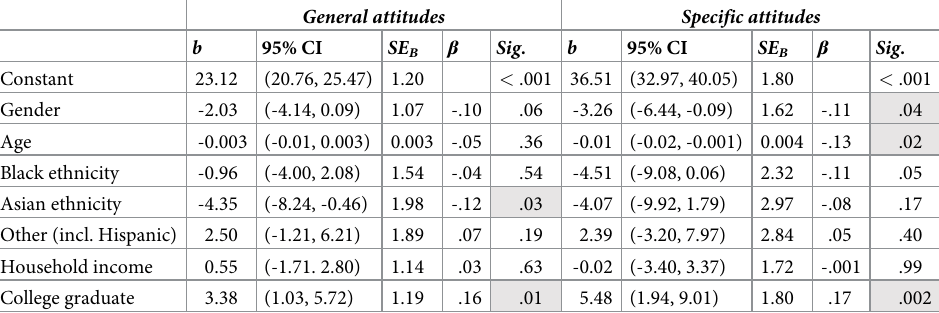
Table 10. Multiple regression for predicting attitudes to easing COVID-19 restrictions for demographic factors.